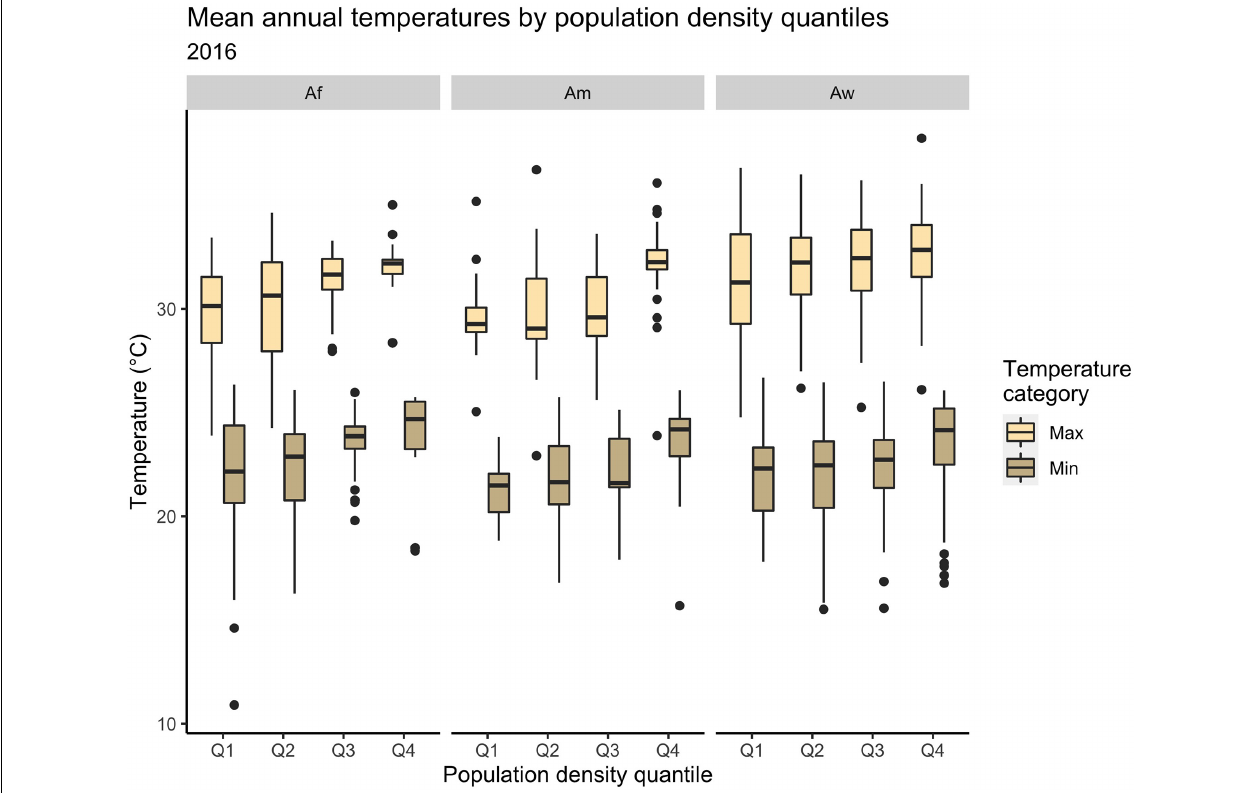
FIGURE 12 | Mean annual temperatures across population density gradients. Data source: NOAA, GHCN and